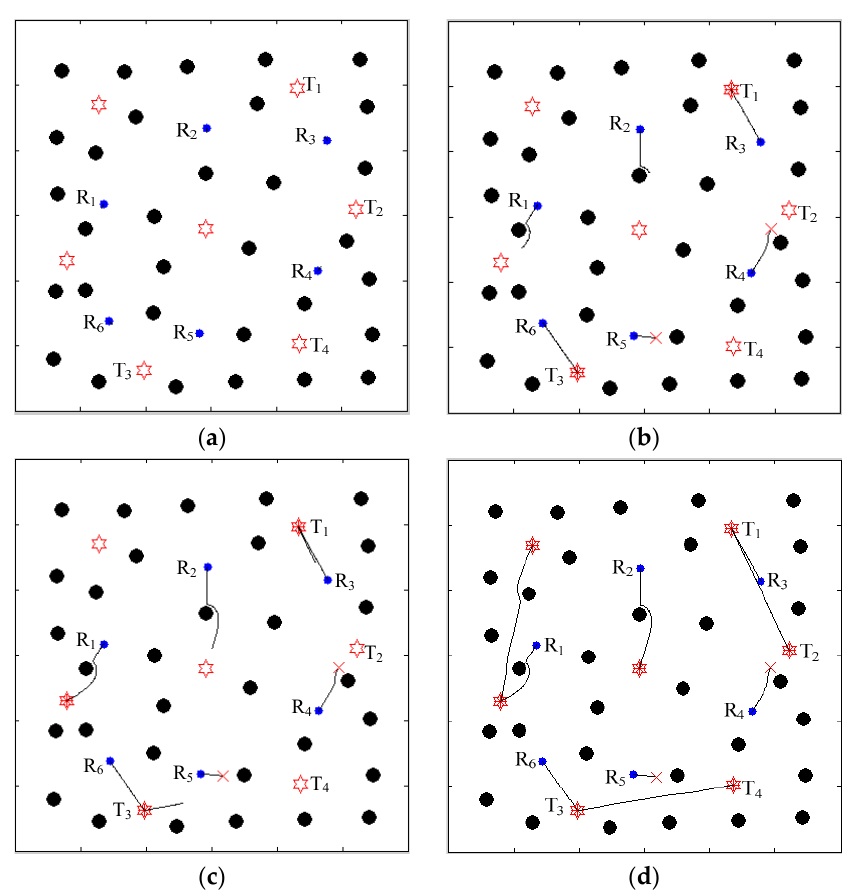
Figure 7. Some robots failed during task execution. ( a ) t = 0, ( b ) t = 50, ( c ) t = 90, ( d ) t = 253.